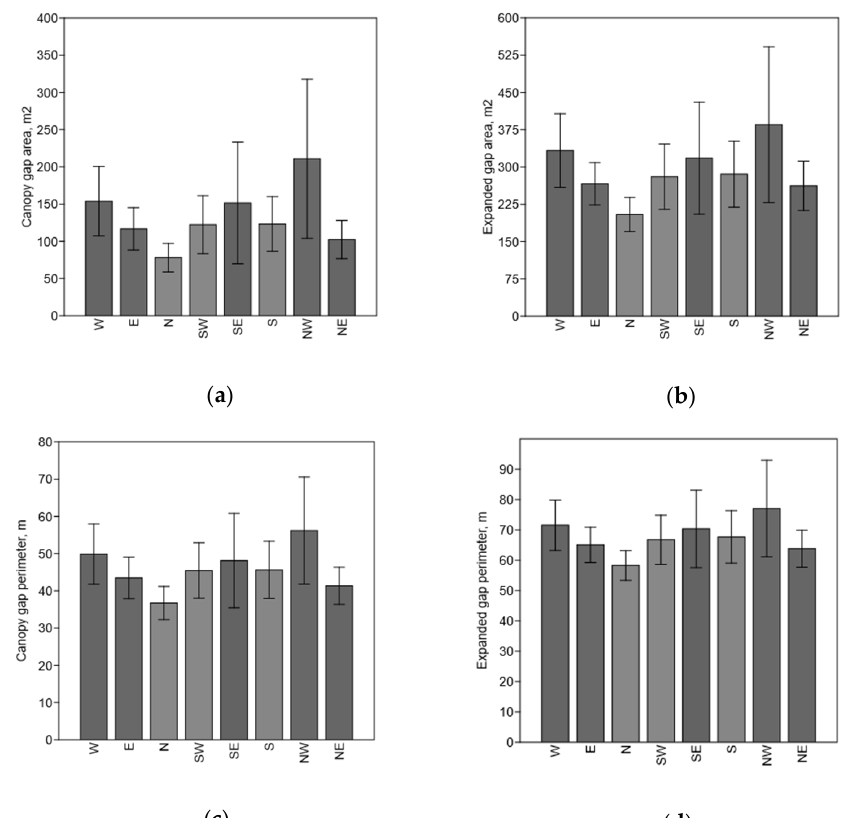
Figure 2. Canopy gap area ( a ), expanded gap area ( b ), canopy gap perimeter ( c ) and expanded gap perimeter ( d ) on aspect categories.